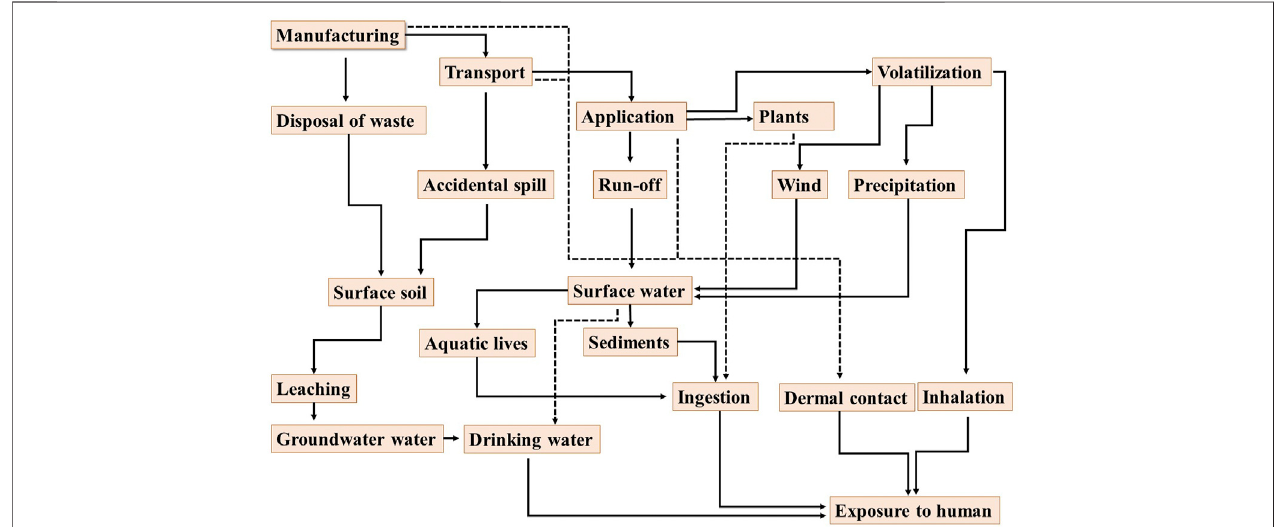
FIGURE 1 | The sources and routs for the introduction of atrazine into various environmental matrices, as well as exposure to the human beings.